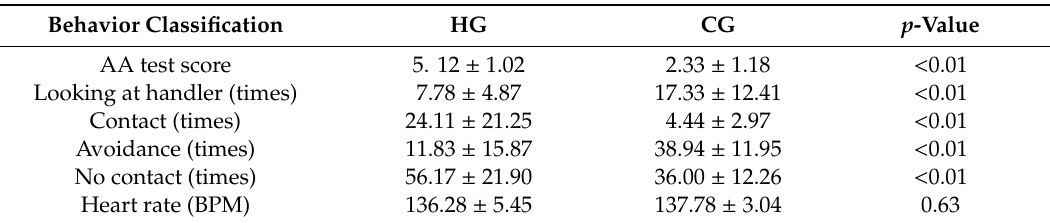
Table 3. E ff ect of gentle handling on the behavioral responses and heart rate of pigs (mean ± standard deviation) ( p <